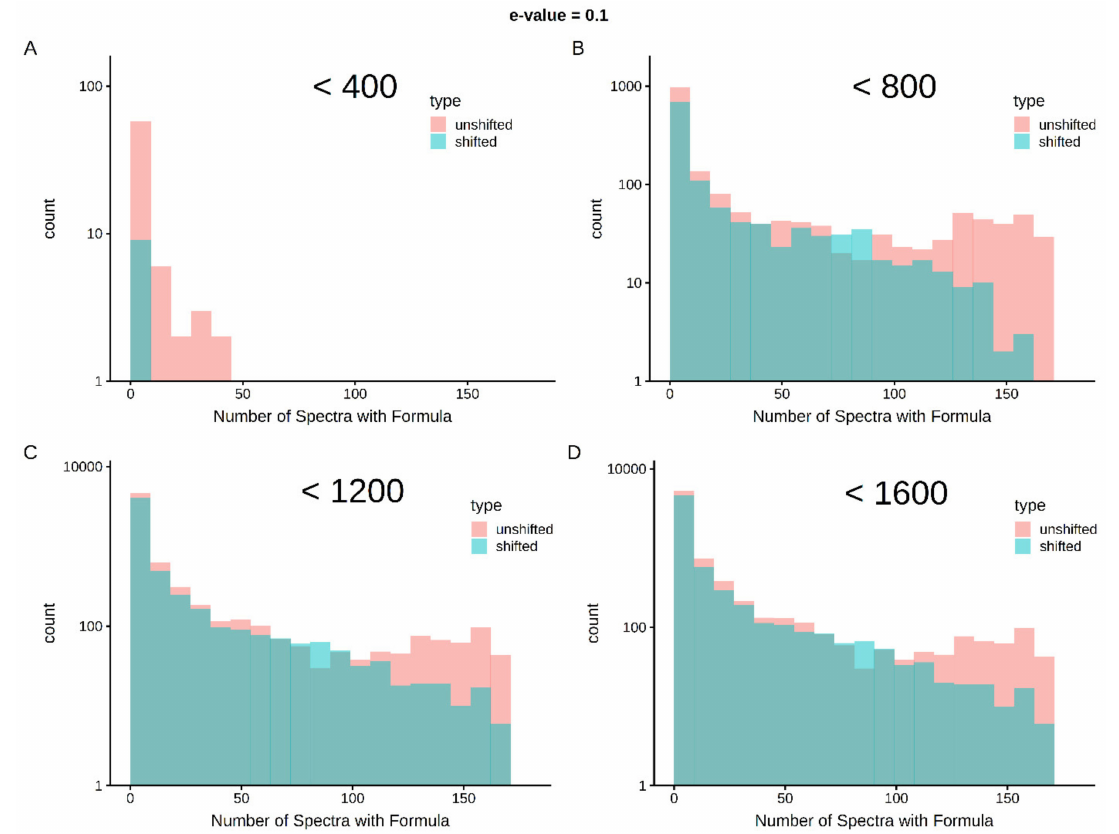
Figure 1. Cross-sample correspondence at E-value <= 0.1 identifies high-quality assignments with lipid classification—correct assignments are expected to occur more consistently within a set of samples than incorrect assignments. As shown in Panel A , below 400 m / z , very few assignments with lipid classification are made in the shifted spectra and very few of the assignments correspond across an appreciable number of spectra (i.e., the vast majority of the first bin represents single spectra assignments). As m / z increases (Panels B – D ), shifted spectra have more assignments and by chance, some of these assignments correspond in multiple samples. However, at up to 1600 m / z , there are clearly more well-corresponding formulas in the unshifted assignments than in the shifted